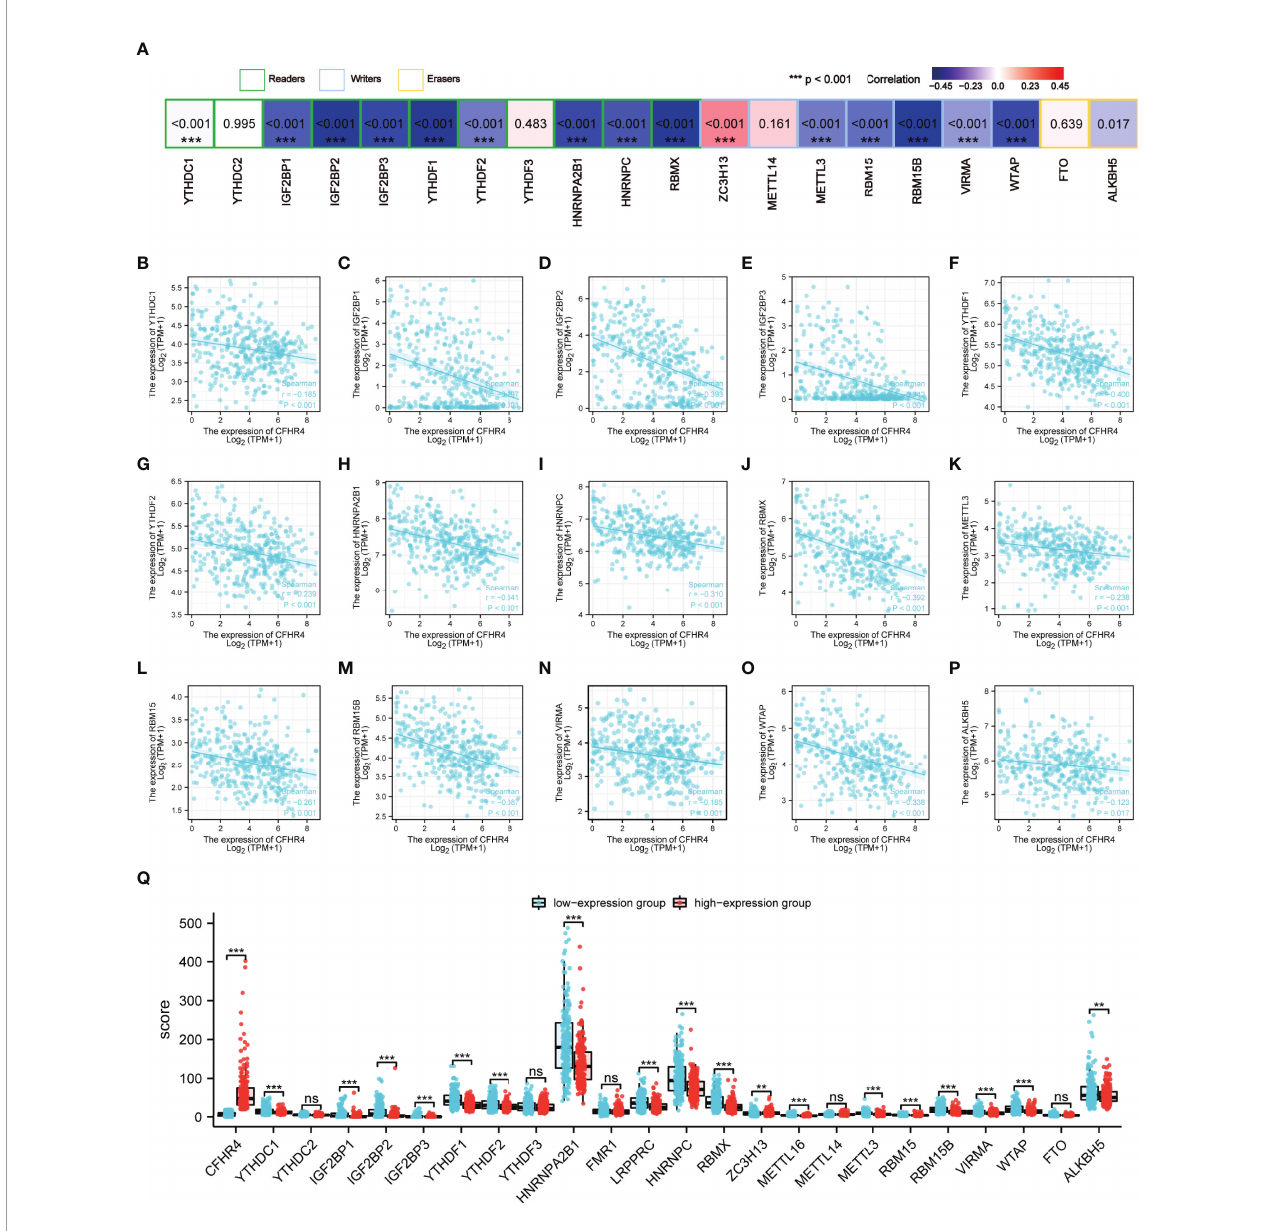
FIGURE 7 | Analysis of the association between the CFHR4 expression level and the expression of m6A-related genes in HCC. (A) Correlation of CFHR4 expression levels with m6A gene expression in HCC. (B – P) Scatter plot showing the relationship between CFHR4 and m6A genes. (Q) Correlation of m6A genes in the CFHR4 high and low expression groups of HCC tumor samples. **p < 0.01, ***p < 0.001, NS, no signi fi